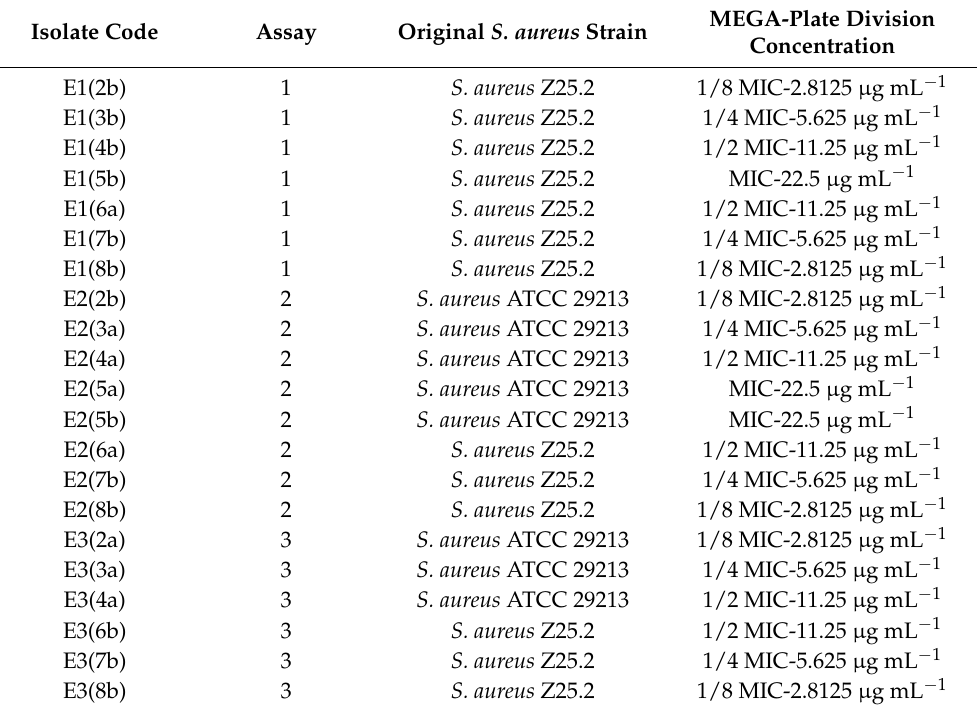
Isolate Code Assay Original S. aureus